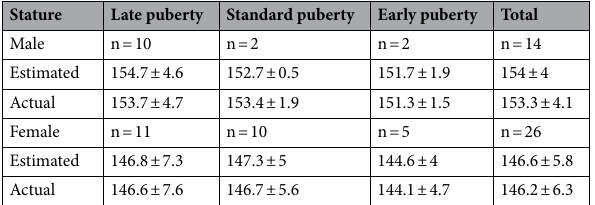
Table 7. Actual and estimated adult stature by maturity stages in the Baka